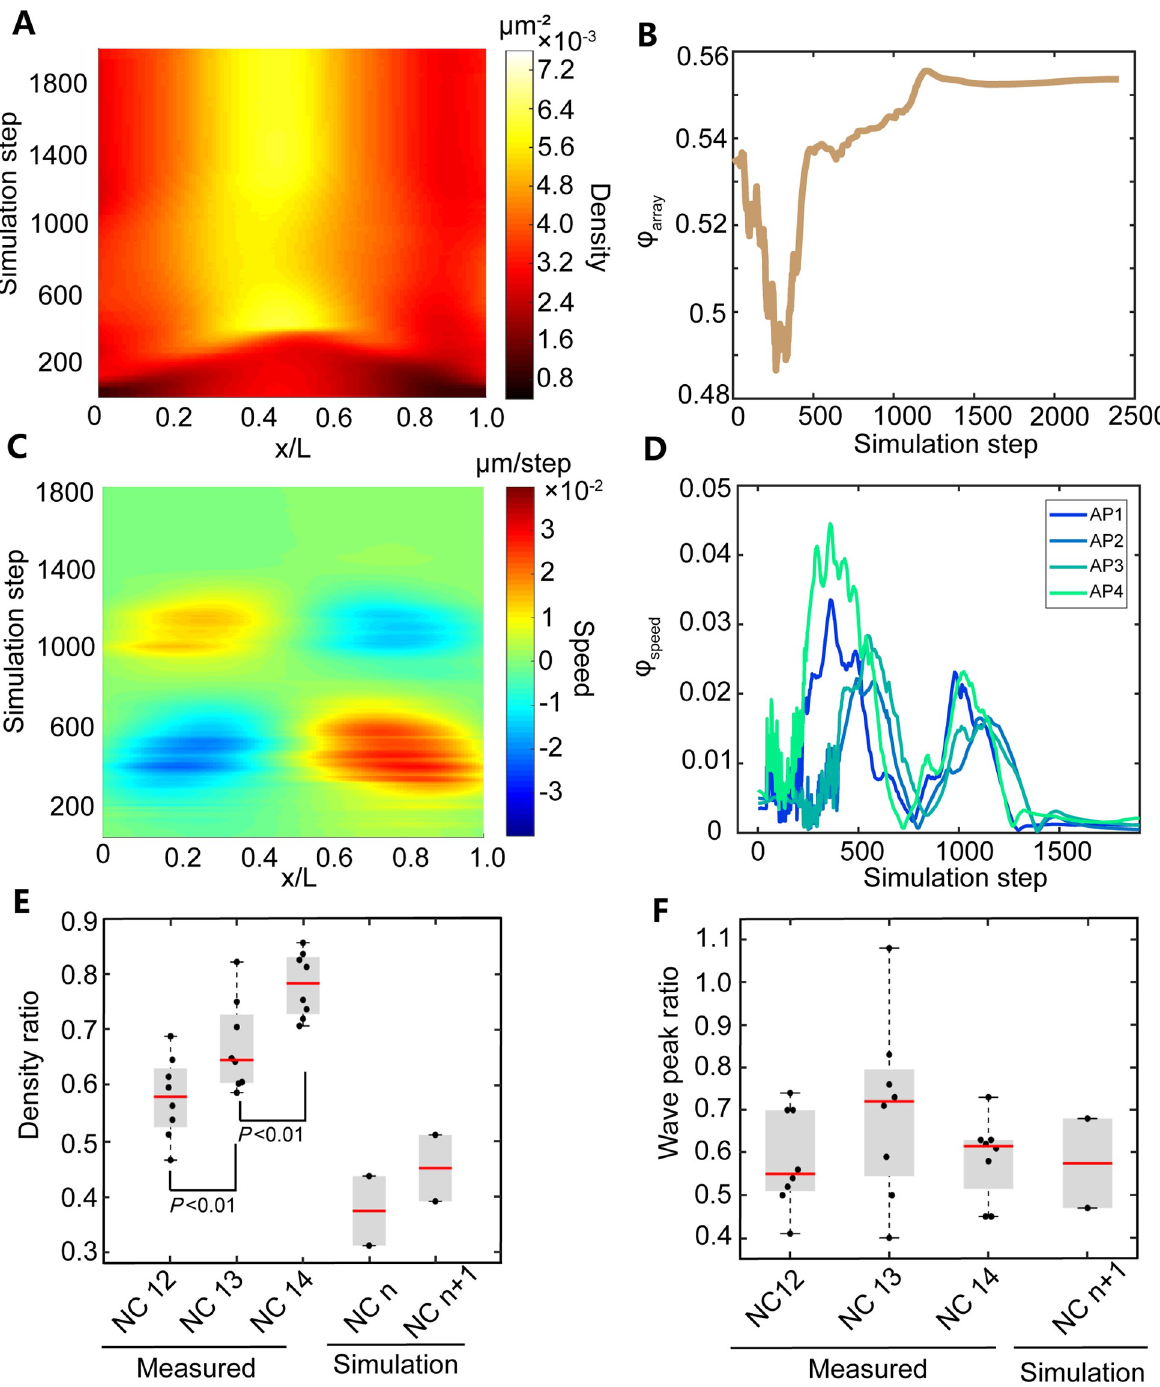
Fig 4. 3D simulation results of the packing pattern and the collective motion pattern of the wild type embryo based on the F a force assumption (for the simulation movie, see S4 Movie). (A) Heat map of the nuclear density projected along the AP axis. (B) The dynamics of hexatic bond-orientational order parameter φ array (see Materials and methods). (C) Heat map of the nuclear speed projected along the AP axis. (D) Dynamics of the order parameter of the collective motion φ (see Materials and methods). APi ( i = 1–4) corresponds to the i th bin with the width speed of 25% EL from the anterior pole (E) Boxplots (whisker, min/max values, boxes, 25/75 percentiles). The medians (red line) of measured and simulated density ratio are 0.58, 0.65, 0.78, 0.37 and 0.45, respectively. Density ratio is defined as the ratio between the anterior (~5–15% EL) or posterior (~85–95% EL) density and the maximal density in the middle of the embryo during interphase. (F) Boxplots (whisker, min/max values, boxes, 25/75 percentiles). The medians (red line) of measured and simulated wave peak ratio are 0.55, 0.72, 0.62 and 0.58, respectively. Wave peak